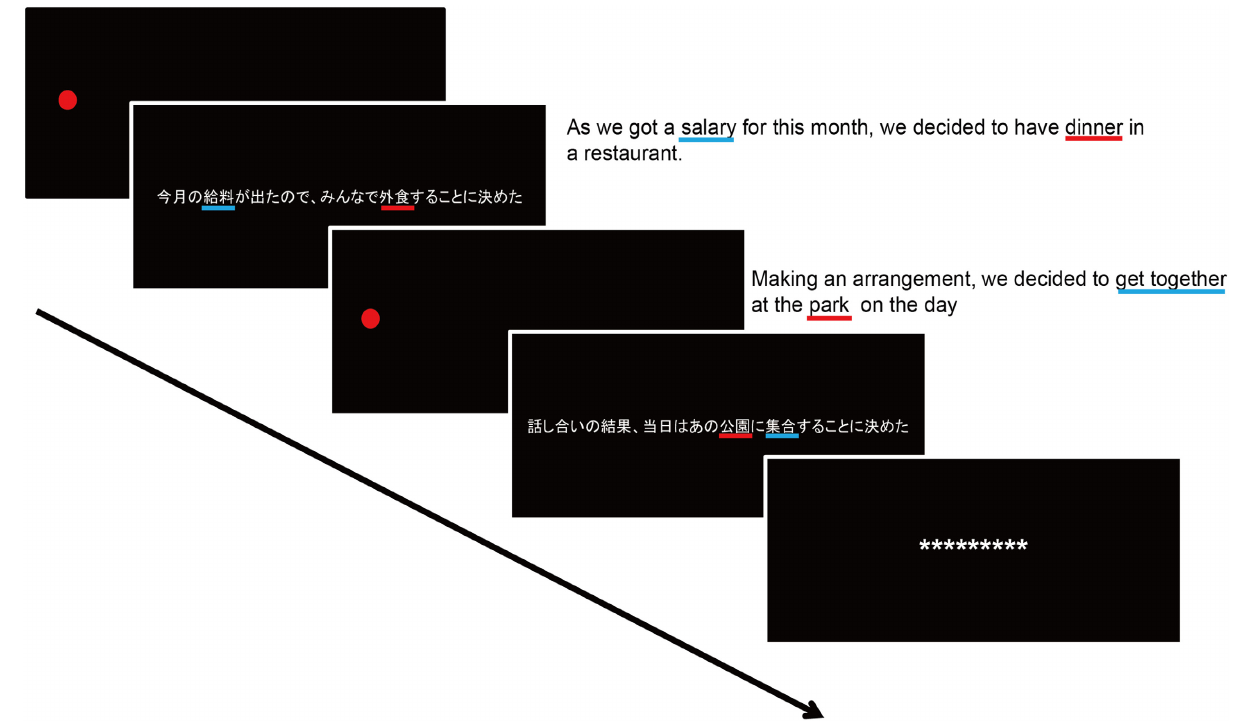
FIGURE 1 | A schematic diagram of the reading span task. A red fixation circle was presented at the beginning of the task, which was followed by a sentence in which a target word was underscore by a red line. Participants were instructed to read a sentence aloud and to remember the target word. After presentation of four